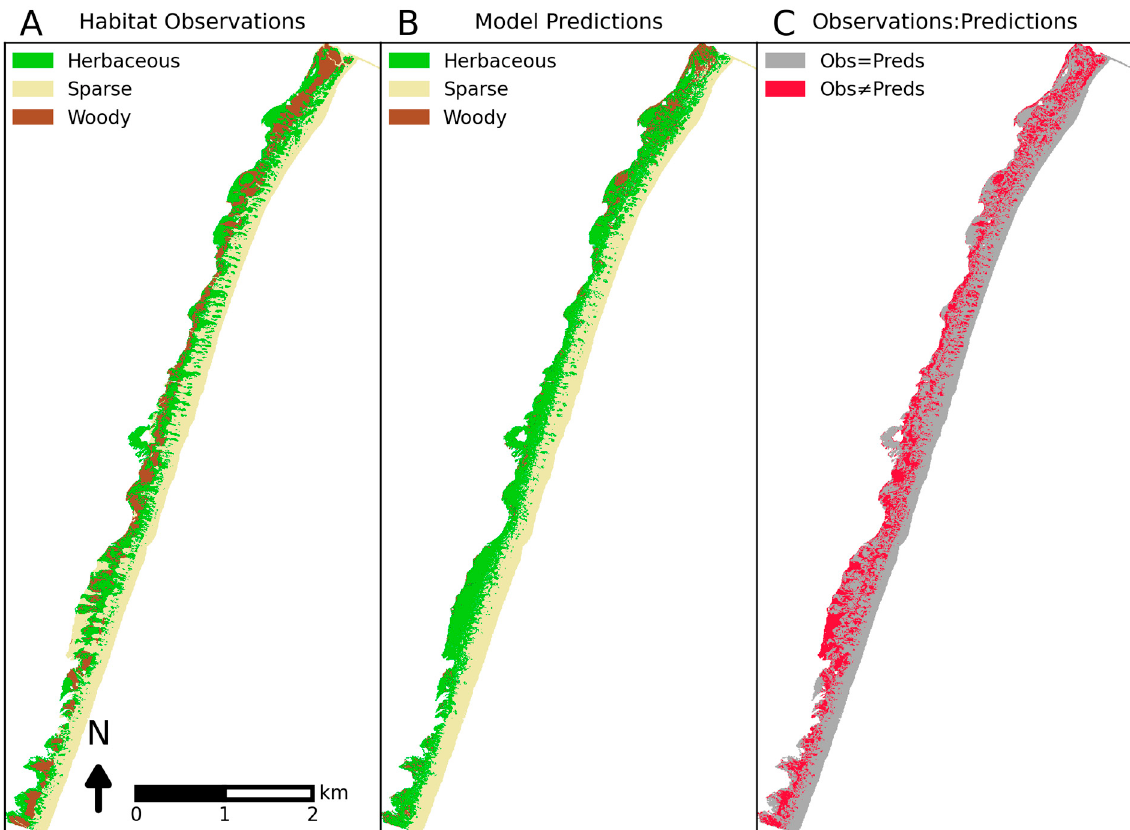
Figure 3. The 2012 habitat observations ( A ), habitat predictions using the equations from Table 4 ( B ), and model accuracy assessment ( C ) in which observations were compared to predictions.